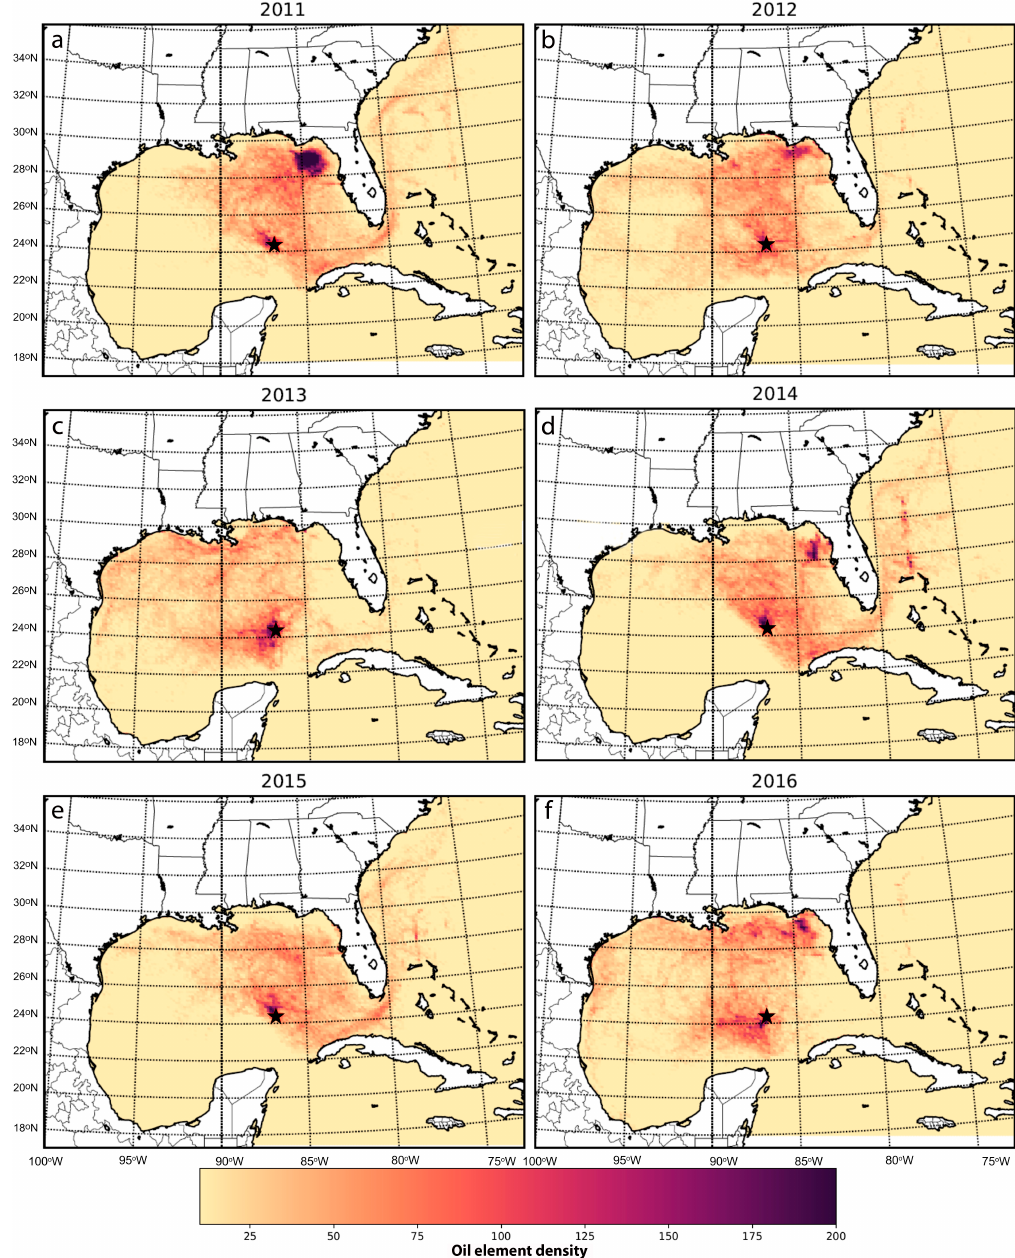
Figure 6. Same as Figure 5 but for Point 5 for ( a ) 2011, ( b ) 2012, ( c ) 2013, ( d ) 2014, ( e ) 2015, and ( f ) 2016.